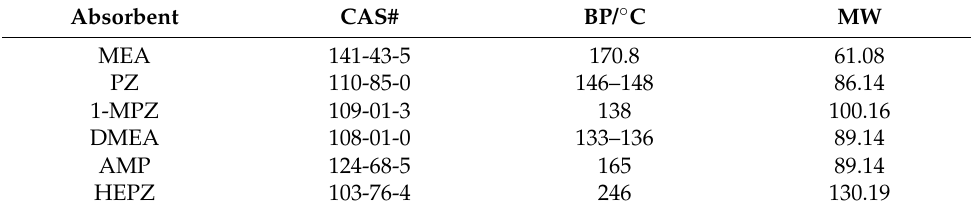
Figure 1. Molecular structure of studied amines. Table 1. The physical parameters and information of solvents.